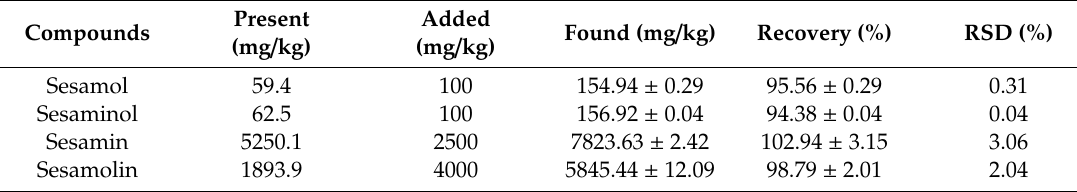
Table 2. Accuracy results for individual lignans spiked in sesame